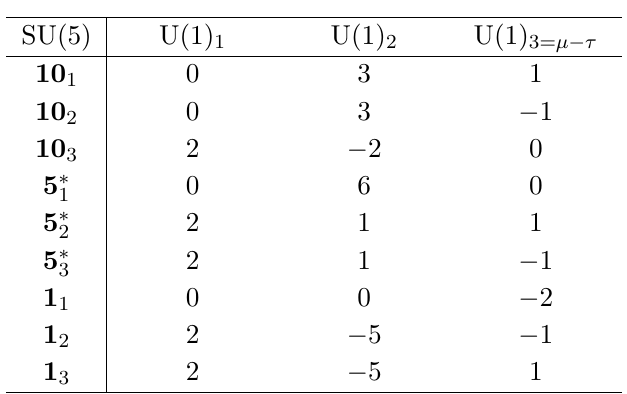
Table 2 . U(1) charges of the NG multiplets in breaking (3.2). The U(1) 1 , U(1) 2 and U(1) 3 are the unbroken U(1)’s of coset-subspaces E 7 /E 6 × U(1), E 6 /SU(5) × SU(2) × U(1) and SU(2)/U(1),